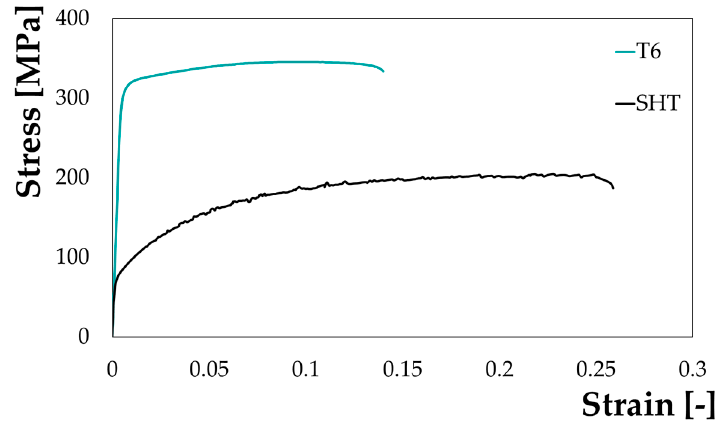
Figure 9. Stress strain curves at room temperature from the uniaxial tensile tests.